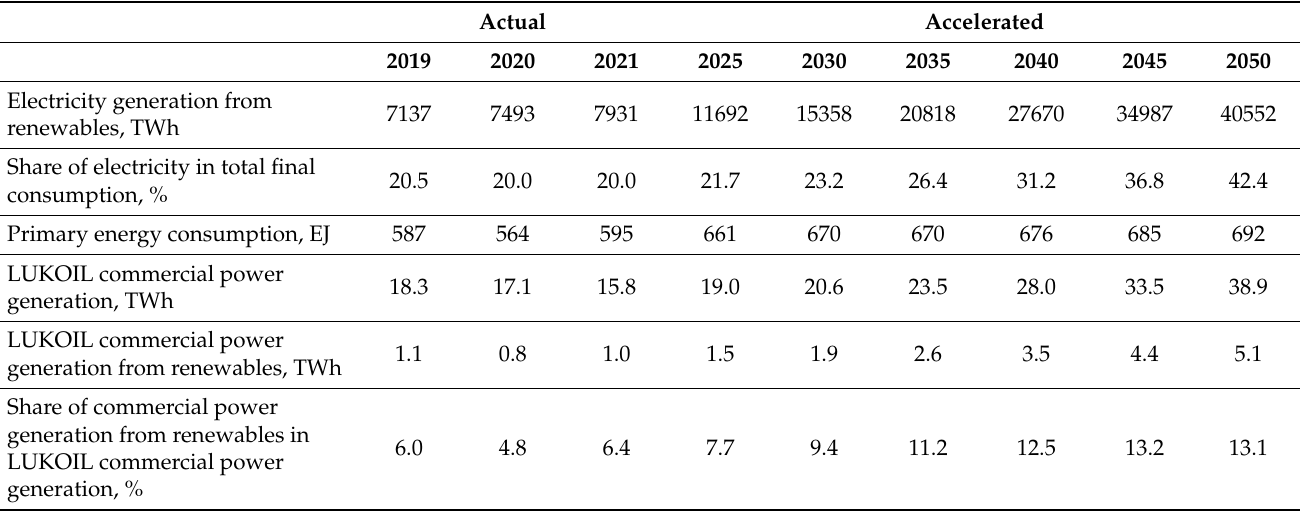
Table 4. Dynamics and forecast of LUKOIL’s commercial power generation from renewables in the scenarios of the development of the energy